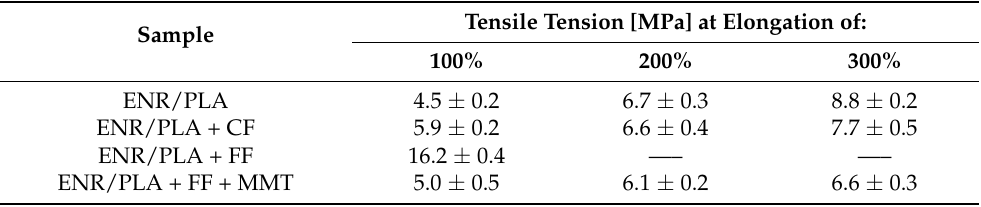
Table 1. Tensile tension at an elongation of 100%, 200%, 300% for the unfilled and filled epoxidized natural rubber/poly(lactic acid) (ENR/PLA) blend